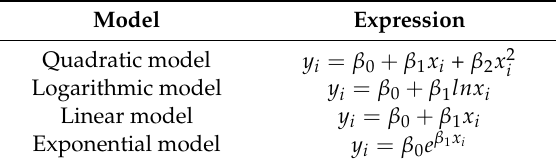
Table 4. Models used to predict the graft growth according to the anatomical characteristics of the scions.